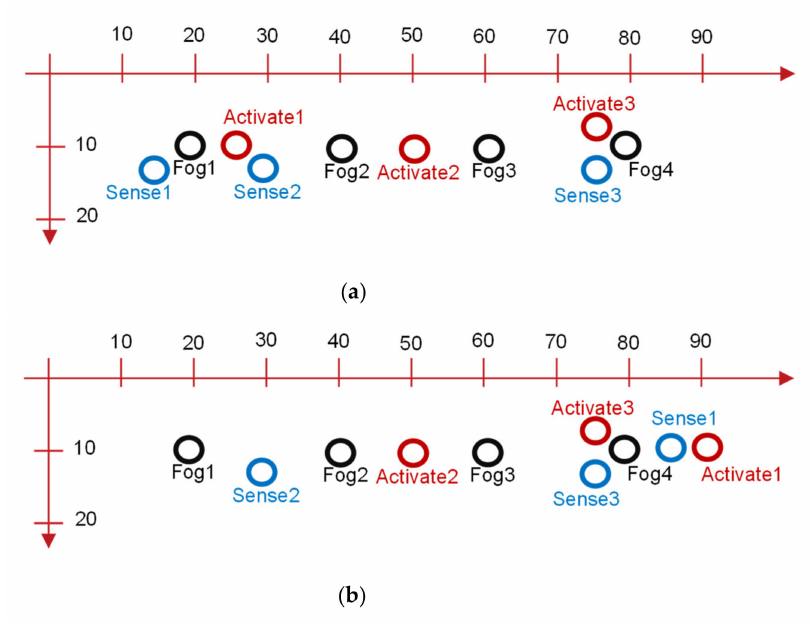
Figure 10. Service placement diagram. ( a ) Initial placement, ( b ) modified placement. Table 7. Best service placement in the third scenario, the initial placement of sensors and actuators.